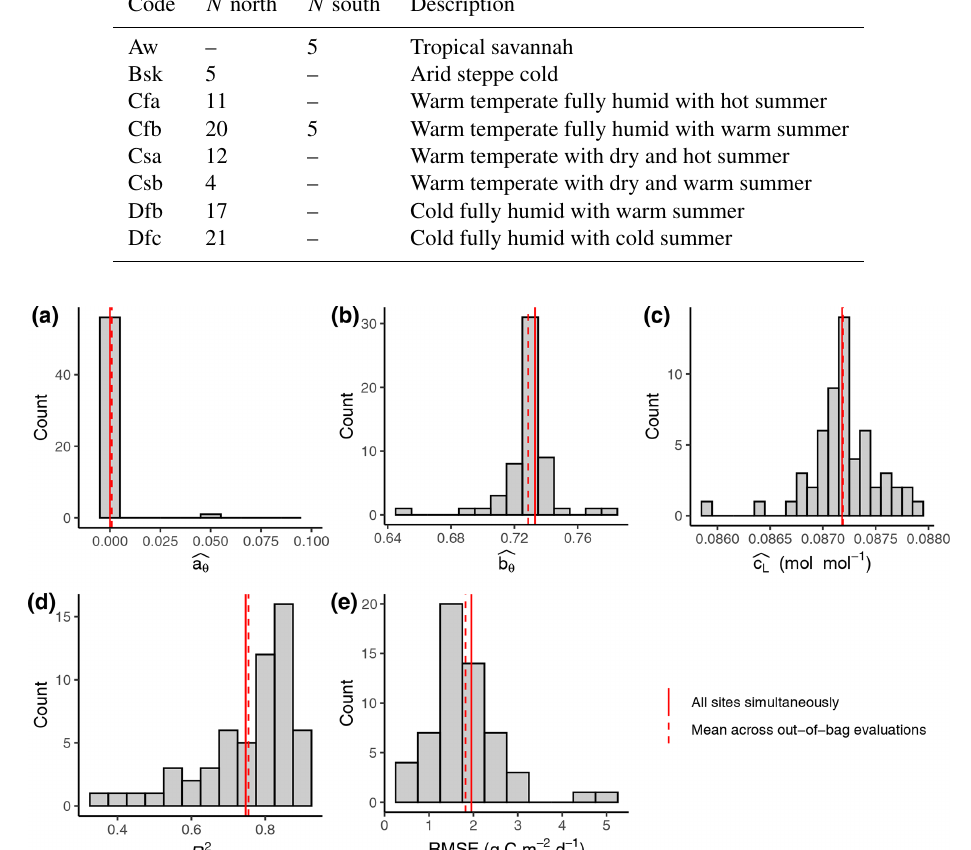
Table 2. Description of Köppen–Geiger climate zones and number of sites for which data are available per climate zone and hemisphere. Sites are classified based on Falge et al. (2017) and Beck et al. (2018). Only zones with data from more than three sites are shown.